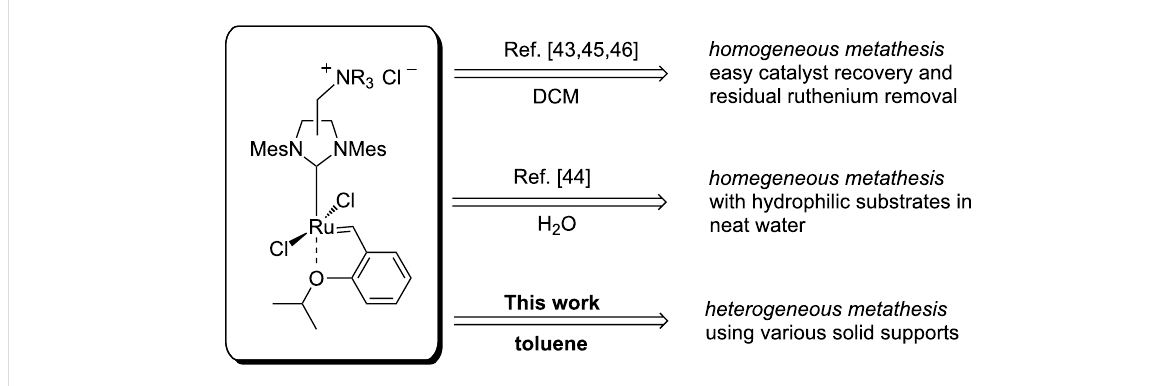
Figure 2: Applications of NHC ammonium-tagged catalysts.